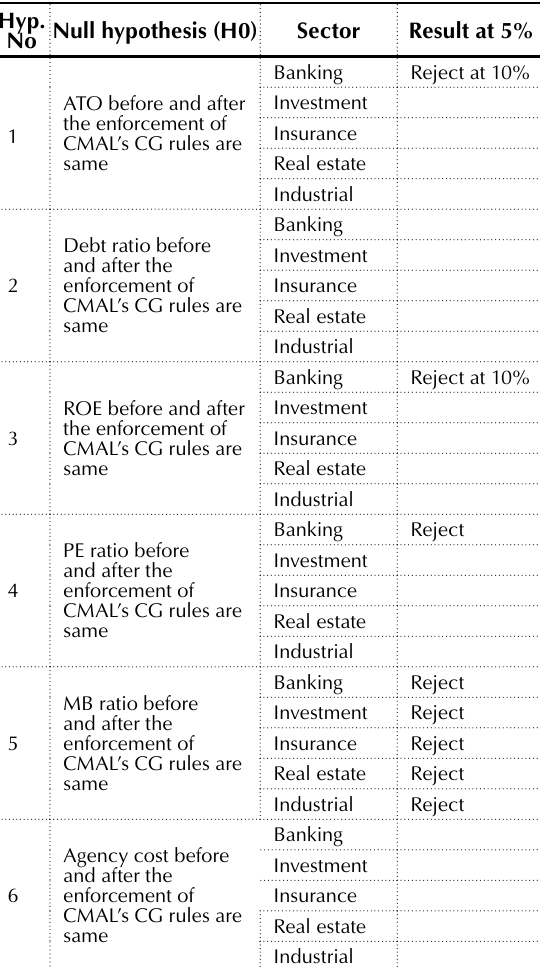
Table 4. Summary of hypotheses testing results based on KCL